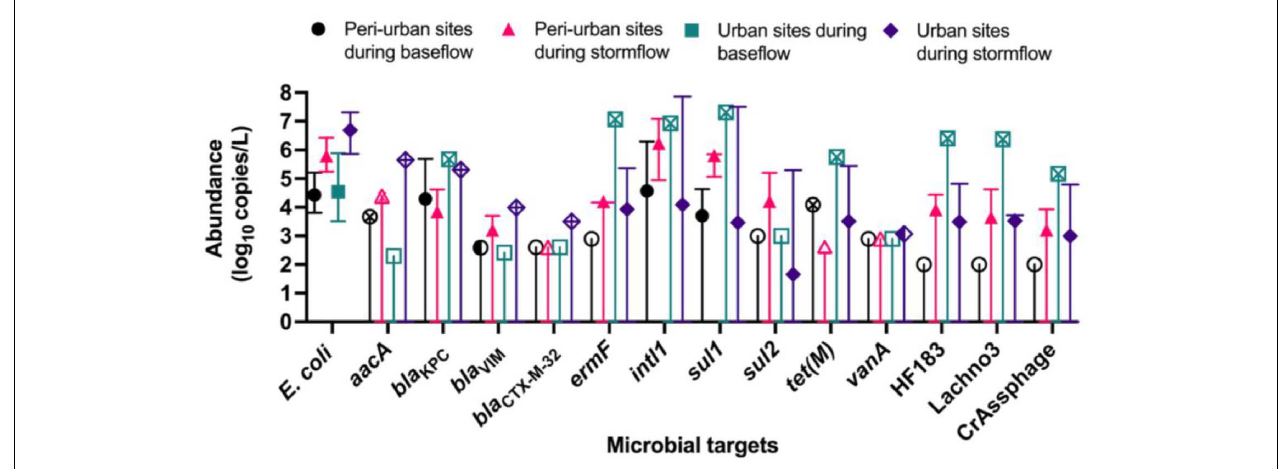
FIGURE 3 | Median abundance (log 10 copies/L) with maximum and minimum abundances (error bars) reported for E. coli (PLOD = 2.00 log 10 copies/L), aacA (PLOD = 2.30 log 10 copies/L), bla ctx − m − 32 (PLOD = 2.60 log 10 copies/L), bla KPC (PLOD = 2.30 log 10 copies/L), bla VIM (PLOD = 2.42 log 10 copies/L), ermF (PLOD = 2.90 log 10 copies/L), intl1 (PLOD = 2.30 log 10 copies/L), sul1 (PLOD = 2.00 log 10 copies/L), sul2 (PLOD = 3.00 log 10 copies/L), tet (M) (PLOD = 2.60 log 10 copies/L), and vanA (PLOD = 2.90 log 10 copies/L), and sewage-associated marker genes (HF183, crAssphage CPQ_056, and Lachno3; all PLOD = 2.00 log 10 copies/L) in water samples collected from peri-urban and urban sites from the Brisbane River system during the base and stormflow (solid-filled shape). If a particular microbial target had left-censored values, the uncertainty of the minimum abundance was depicted with a straight, vertical line. If it was not possible to calculate a median abundance ( > 80% left-censored), then the maximum abundance measured was depicted with an “X” inside the site/flow shape. When a microbial target was only detected below the limit of quantification, then a half-filled shape depicted the limit of quantification. Finally, an un-filled shape represents 100% left-censored values, and the process limit of detection is